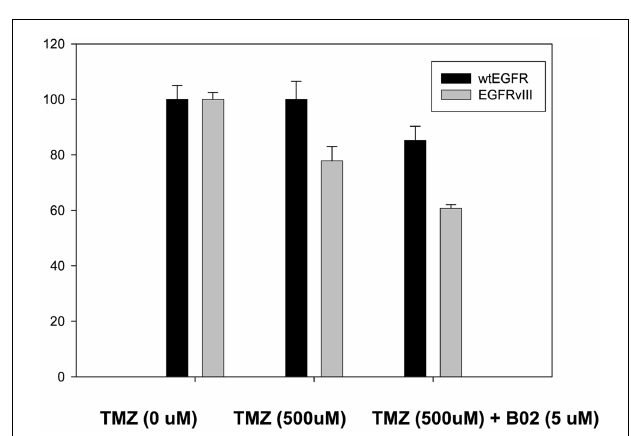
FIGURE 4 | Effect ofAkt inhibitor (BAY 1001931) on nuclear accumulation of Rad51 foci 24h followingTMZ treatment in U87wtEGFR and U87EGFRvIII cells. (A) Fold-change in nuclear Rad51 foci relative to control levels. (B) Micrographs showing DAPI